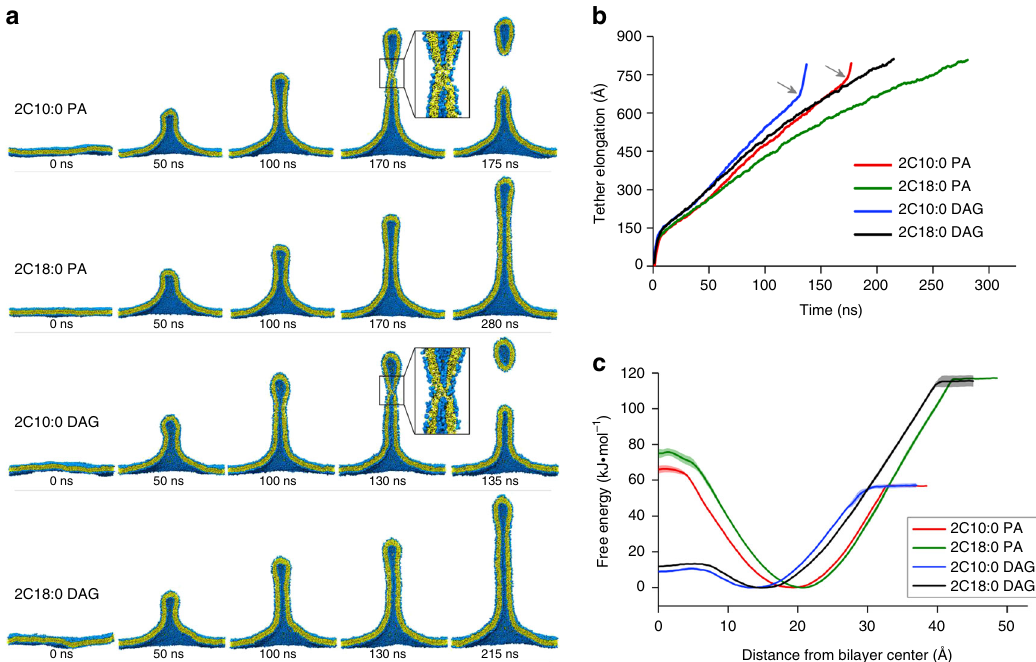
Fig. 4 Coarse-grained molecular dynamics simulations. Membranes contain 70% dioleoyl-phosphatidylcholine and 30% of phosphatidic acid (PA) or diacylglycerol (DAG) in forms as indicated. a When force is exerted on membranes that contain shorter (2C10:0) PA or DAG, membrane tubulation occurs, followed by fi ssion. However, when force is exerted on membranes that contain longer (2C18:0) PA or DAG, membrane tubulation occurs, but no fi ssion is observed. Cross-sections of tubulated membranes are shown. Water and ions are not shown for clarity. Fission events are highlighted by inset, which shows the fusion of the inner layer of the tubulated membrane bilayer. Replica of four was performed, with a representative result shown. b Membranes containing shorter PA/DAG possess higher elongation rate and undergo a sudden in fl ection (indicated by gray arrows and corresponding to membrane fi ssion) when the elongation distance reaches ~700 Å. c Potential of mean force (PMF) pro fi les for different forms of PA and DAG. PMF was set to zero at the equilibrium position (free energy minimum) of a lipid in the membrane bilayer, which is approximately 15 – 20 Å from the center of the bilayer. For a lipid moving away from the bilayer center (toward 40 Å), the free energy barrier is lower for shorter PA/DAG. For a lipid moving toward the bilayer center (toward 0 Å), the free energy barrier is lower for DAG